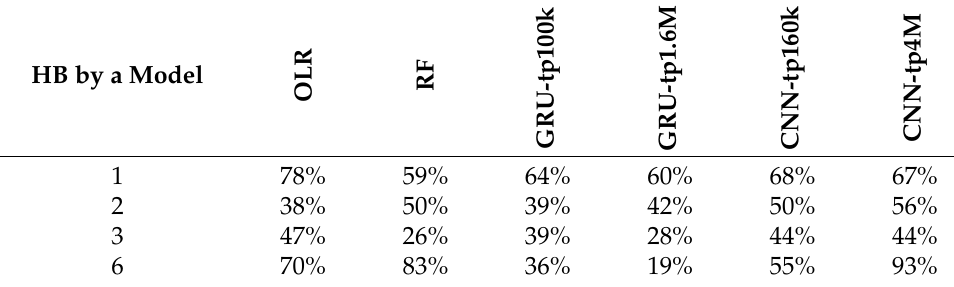
Table 6. Comparison of precision of classification of all